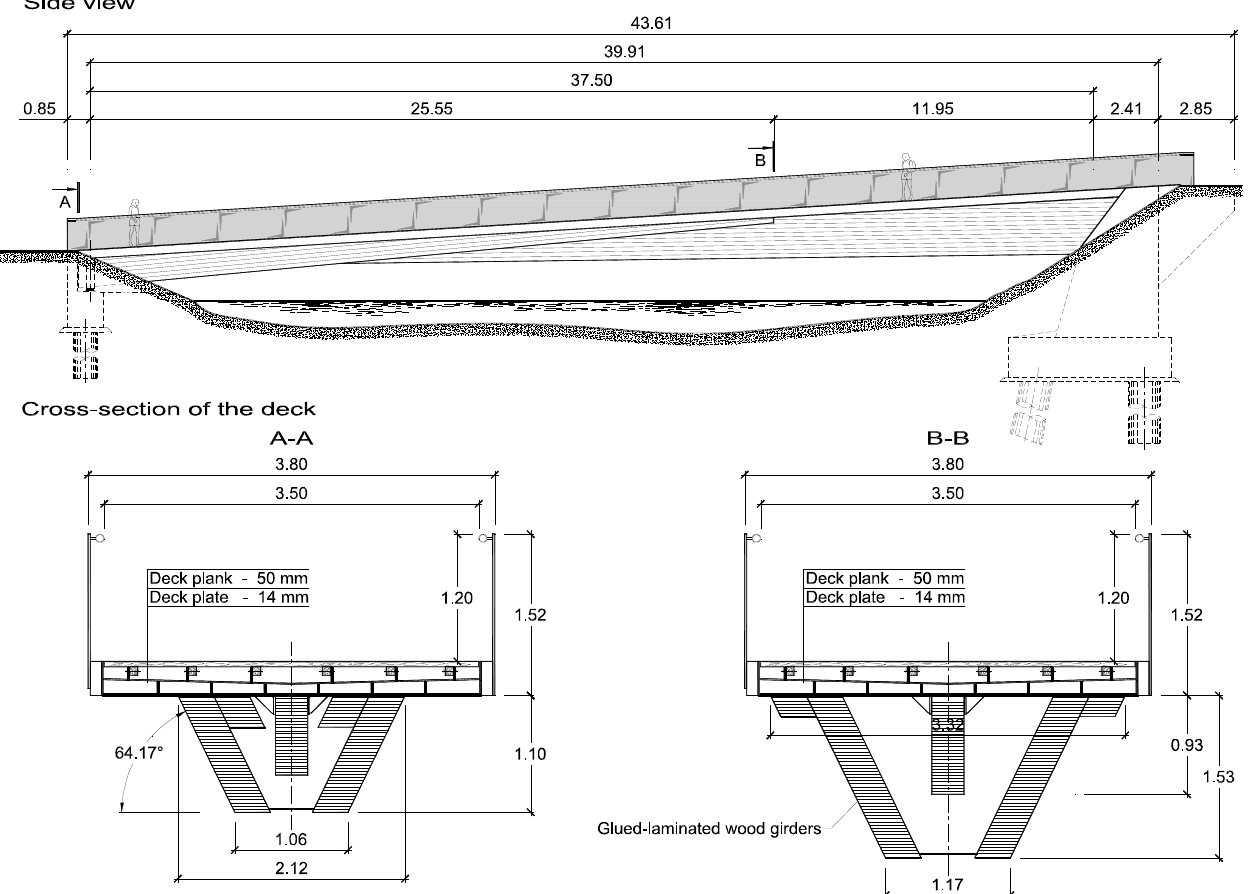
Figure 7. Structural solutions of the footbridge in Wroc ł aw. Design conditions forced the footbridge to be built to about 40 m in length. Its width has been specified to be 3.50 m. A difference in ground level between both of the moat’s banks caused the longitudinal slope of the footbridge to be about 6%. The footbridge was designed for pedestrians, as well as